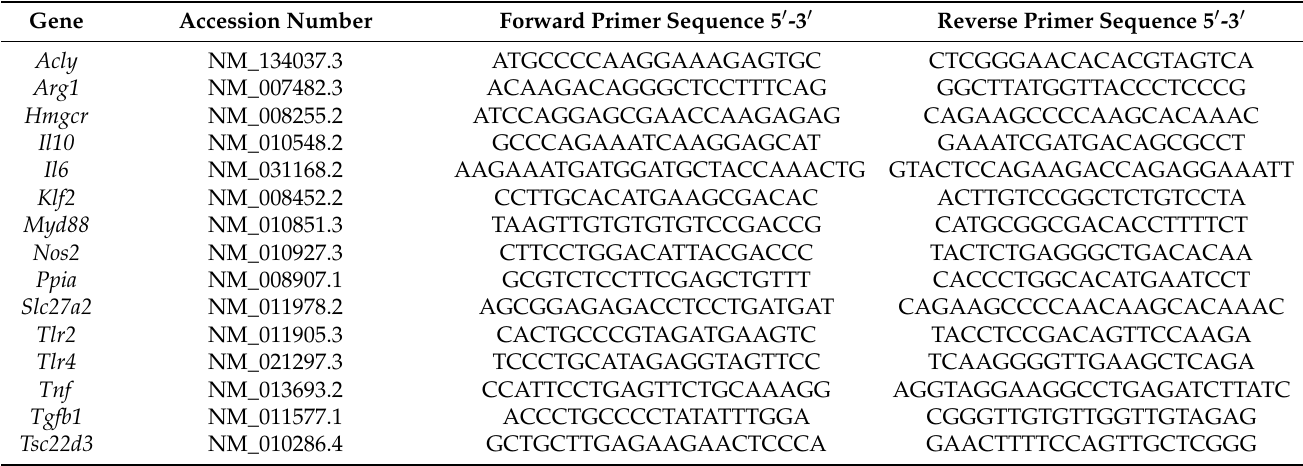
Table 1. Primer sequences for RT–qPCR